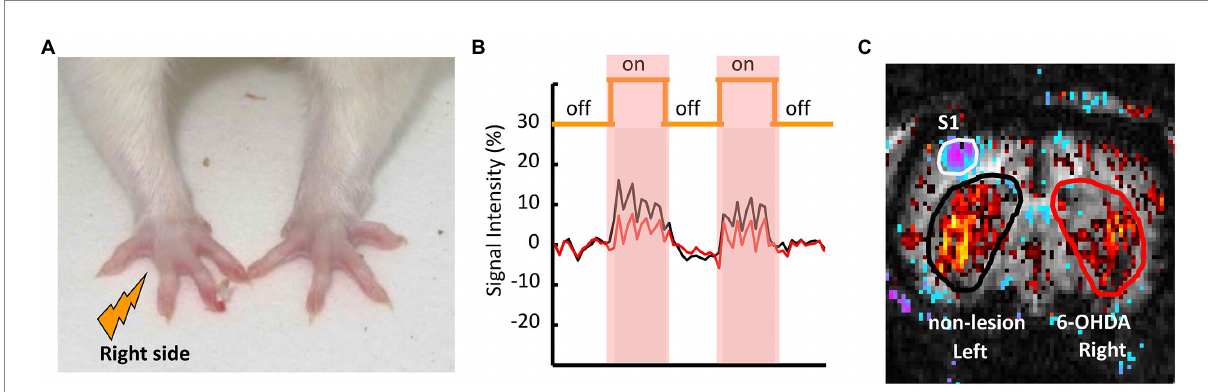
FIGURE 3 Representative fMRI scan of a PD rat and the positions of the ROIs in the 6-OHDA-lesioned and non-lesioned hemispheres. (A) Nociceptive electrical stimulation was applied to the right forepaw of the PD rat via a pair of needle electrodes. (B) The time course of CBV signal intensities during nociceptive stimulation in the left (intact: black) and right (lesioned: red) striata of the PD rat. (C) The ROIs for the left non-lesioned striatum are shown in black, and in red for the right 6-OHDA-lesioned striatum.